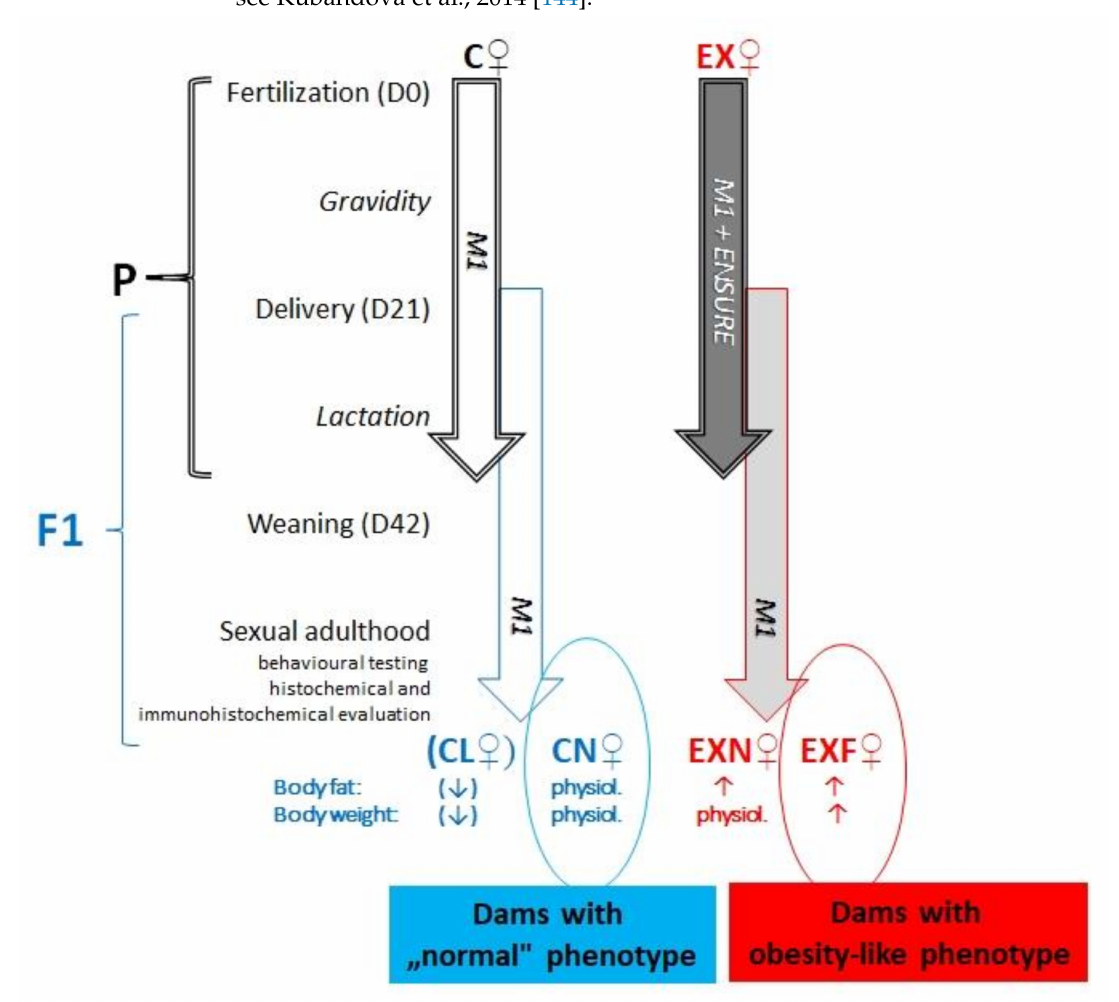
Figure 8. Intergenerational dietary model. Scheme depicts the dietary regime of two generations of mice used in this study. Abbreviations: P—parental generation; F1—the first filial generation; M1—standard pellet diet, ENSURE—diet supplement with Ensure PLUS; C—control group of mice; EX—experimental group of mice; (CN) control group of mice characterized by normal weight and physiological percentage of body fat deposits; (CL) control group of mice characterized by reduced weight and reduced body fat deposits; (EXN) experimental group of mice characterized by normal weight and moderately elevated body fat deposits; (EXF) experimental group of mice characterized by markedly elevated weight and body fat